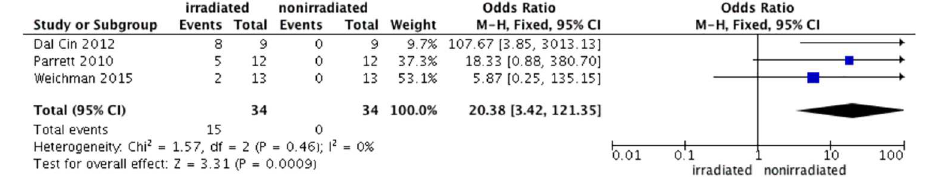
Fig 8. Correlations between radiation and infection.